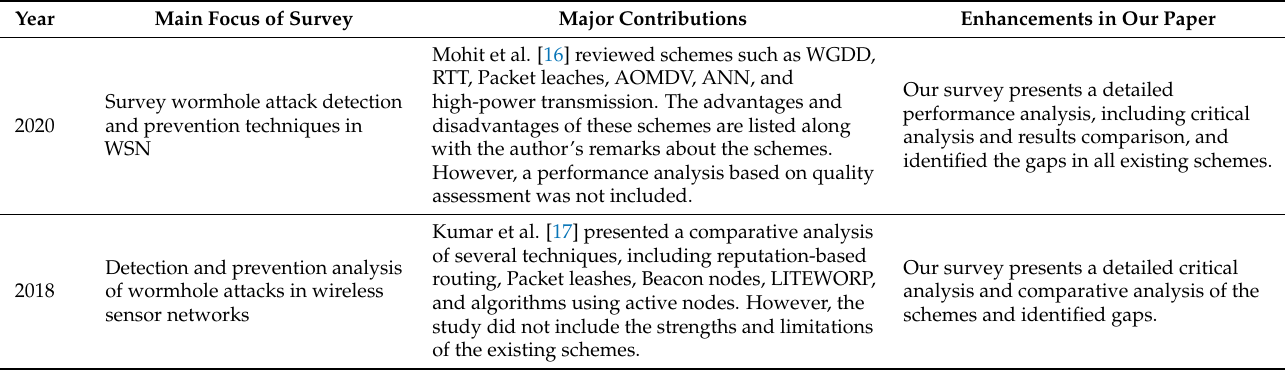
Table 1. Summary of surveys of wormhole detection Figure 2. External wormhole attack with high power transmission.